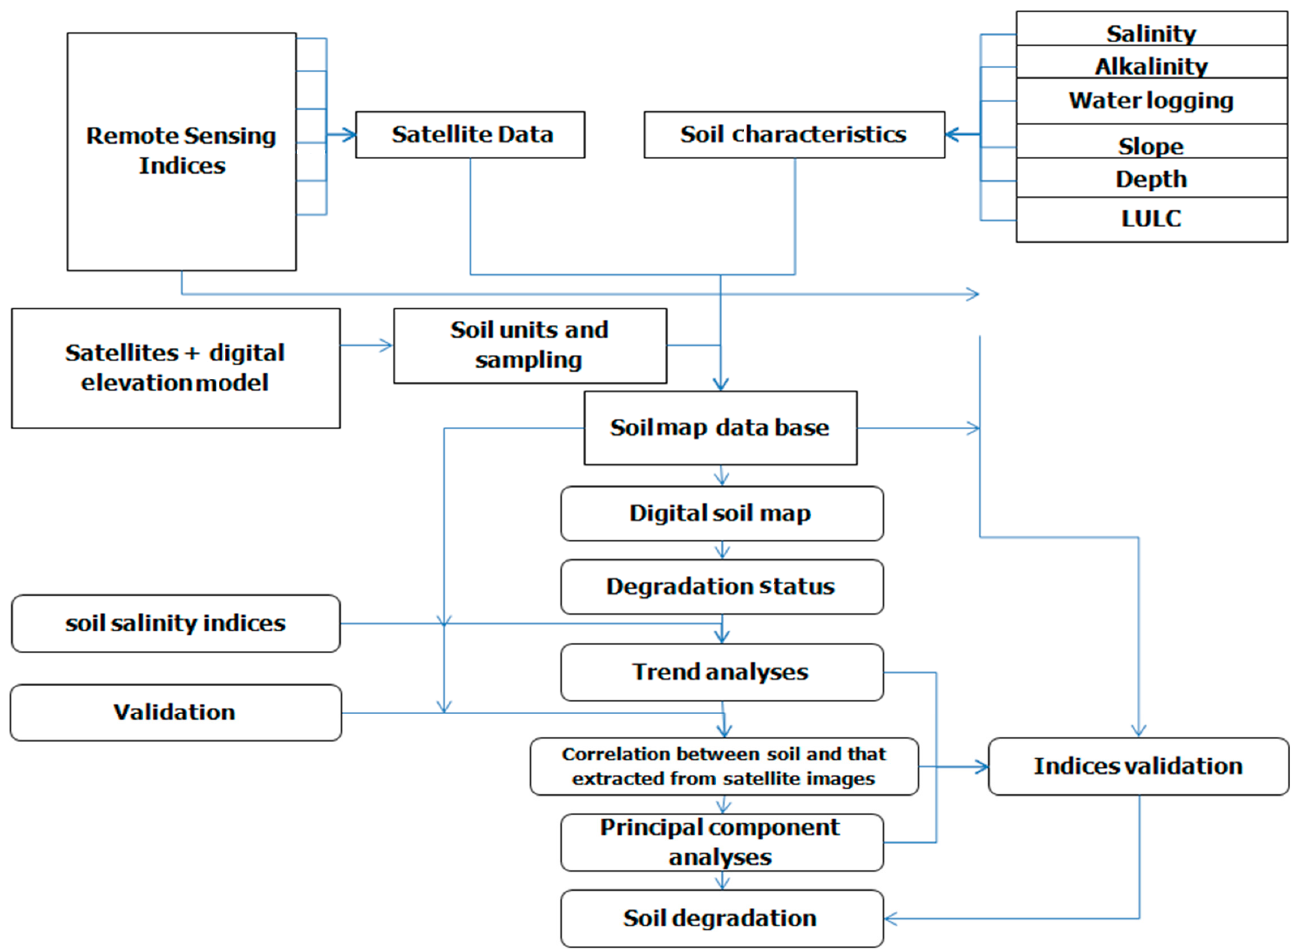
Figure 4. Flowchart of the work steps.